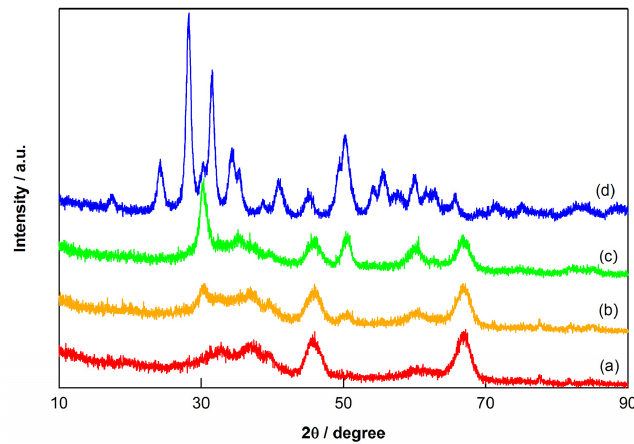
Figure 5. X ‐ ray diffraction patterns of ( a ) 5%ZrO 2 –Al 2 O 3 , ( b ) 10%ZrO 2 –Al 2 O 3 , ( c ) 20%ZrO 2 –Al 2 O 3 , and ( d ) ZrO 2 .